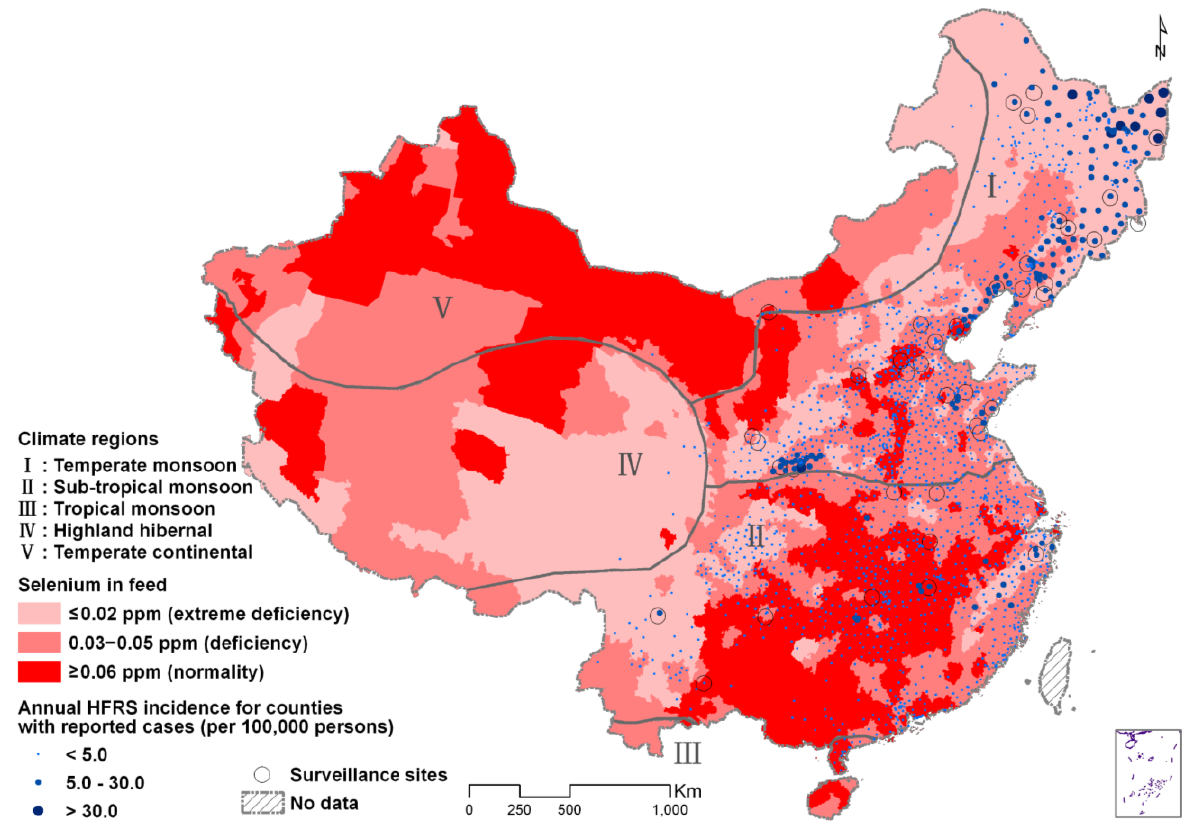
Figure 1. Geographic distribution of hemorrhagic fever with renal syndrome (HFRS) incidence in relation to selenium content of crops and feed in Mainland China. The background of the map with color gradient presents the selenium content of crops and feed, and the dots with size and color gradient display the average annual incidence of HFRS from 2005 to 2010. Areas without dots do not have reported cases of HFRS. The thick grey lines are boundaries of the five climate regions of China. The thin black circles indicate the 40 surveillance sites for hantavirus infection in rodent hosts (used in Figure 2). Ppm is parts per